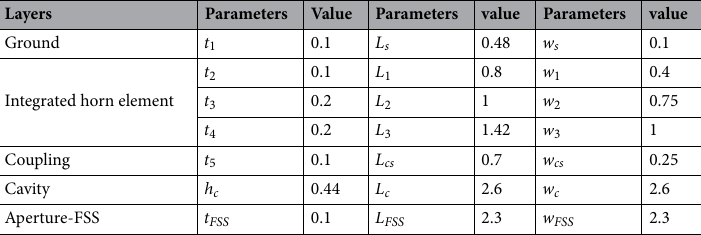
Table 1. Antenna design parameters (Units: